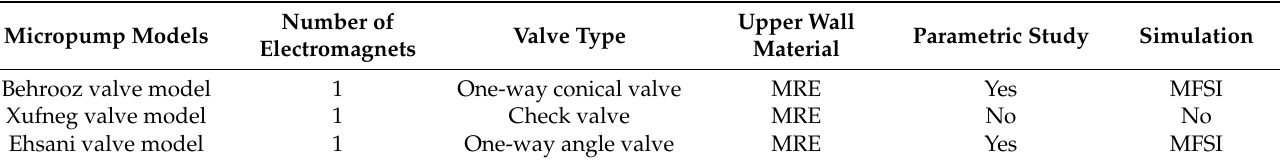
Table 1. Existing magnetorheological micropump designs in the